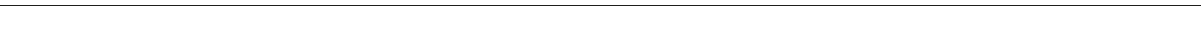
Fig. 1 High-throughput mutagenesis screen provides quantitative splicing information across the RON minigene. a High-throughput detection of splicing- effective mutations. Mutagenic PCR creates mutated minigene library (left) that gives rise to alternatively spliced transcripts (middle). Mutations and corresponding splicing products are characterised by DNA and RNA sequencing, respectively, and linked by unique 15-nt barcode sequence in each minigene (coloured boxes). Black and grey boxes depict constitutive and alternative exons, respectively. b Nine most frequent isoforms found in HEK293T cells. Bar diagram shows total frequency in RNA-seq library (black) and maximal frequency for any individual minigene variant (grey). Asterisks mark non-canonical isoforms from cryptic 3 ′ splice site usage upon mutations at positions marked in g . AE, alternative exon, IR, intron retention, other, non-canonical isoforms. c Occurrence of distinct splice junctions in HEK293T cells. Line thickness and colour represent number of minigene variants producing a given junction (only junctions accounting for ≥ 1% of all junctions for a given minigene). d Boxplot showing distribution of AE inclusion frequencies (as % of all isoforms) for all wild-type (wt) and mutated minigenes and a subset with mutations in splice sites (ss) of RON exon 11. Boxes represent quartiles, centre lines denote 50th percentile, and whiskers extend to most extreme values within 1.5× interquartile range (IQR). e Validation of AE inclusion frequencies for 59 randomly selected minigene variants. Scatterplot compares the RNA-seq quanti fi cation to semiquantitative RT-PCR for individual minigene variants in HEK293T cells. r , Pearson correlation coef fi cient and associated P value. f Mutational landscape around the 3 ′ splice site of RON exon 11. Boxplot of AE inclusion frequencies in HEK293T cells for all minigenes with mutation at indicated positions ( x -axis). Box representation as in d . Colours illustrate inserted nucleobase (see legend). Blue and purple lines indicate IQR of AE inclusion frequencies for all mutated and wt minigenes, respectively. Sequence of wt RON minigene given below. g Isoform frequencies arising from mutations along RON minigene. Stacked bar chart shows median frequency of six isoform categories for all minigenes with mutation at a given position. Average of three biological replicates in HEK293T cells. Asterisks highlight positions where mutations lead to non-canonical isoforms depicted in